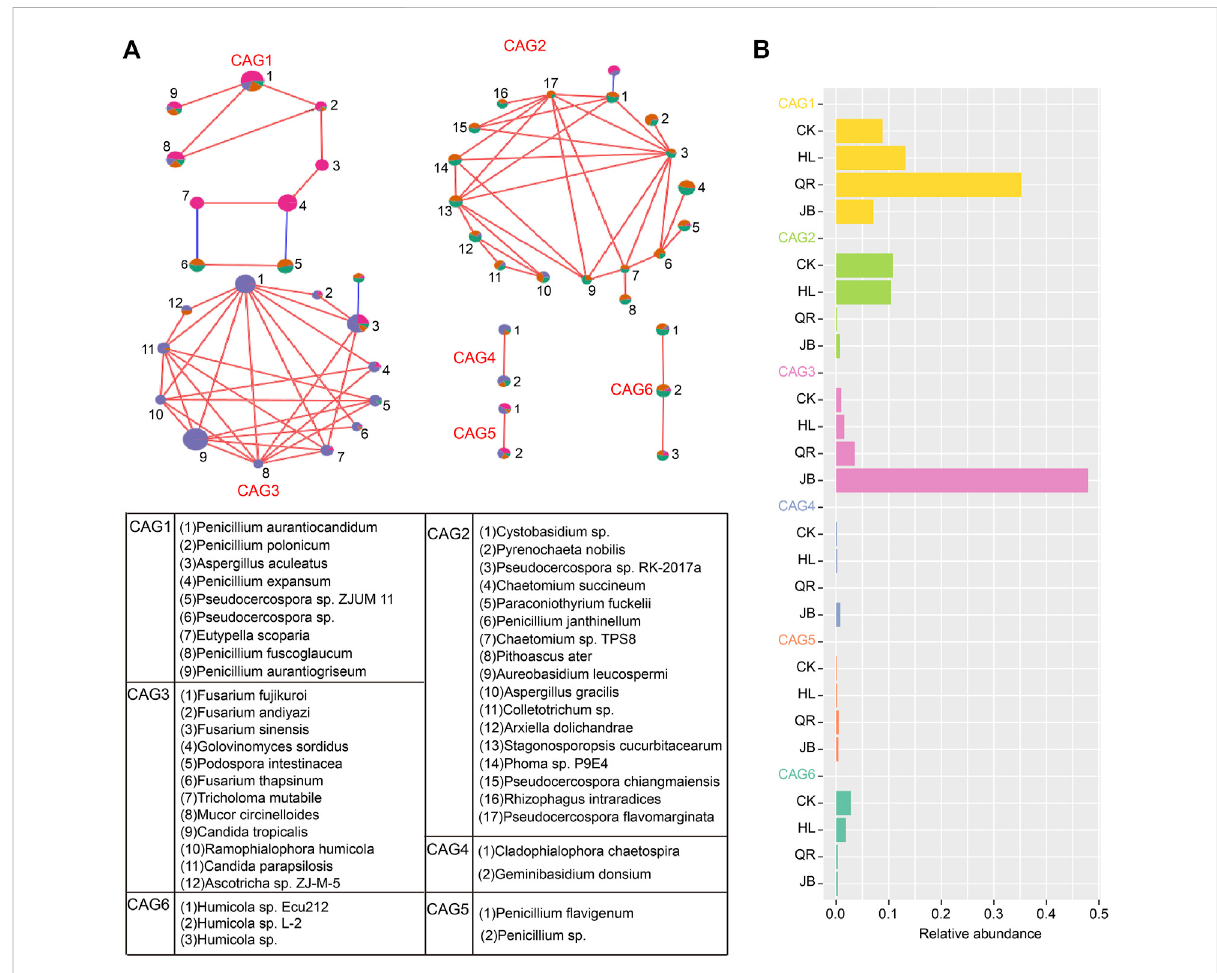
FIGURE 6 Co-abundance genes group (CAG) as a gut fungal functional set wasidenti fi ed bySparCC analysis (A) The compositionof fi vegut fungal CAGs. Red lines represent positive correlation and blue lines represent negative correlation. (B) The relative abundance of fi ve CAGs in four